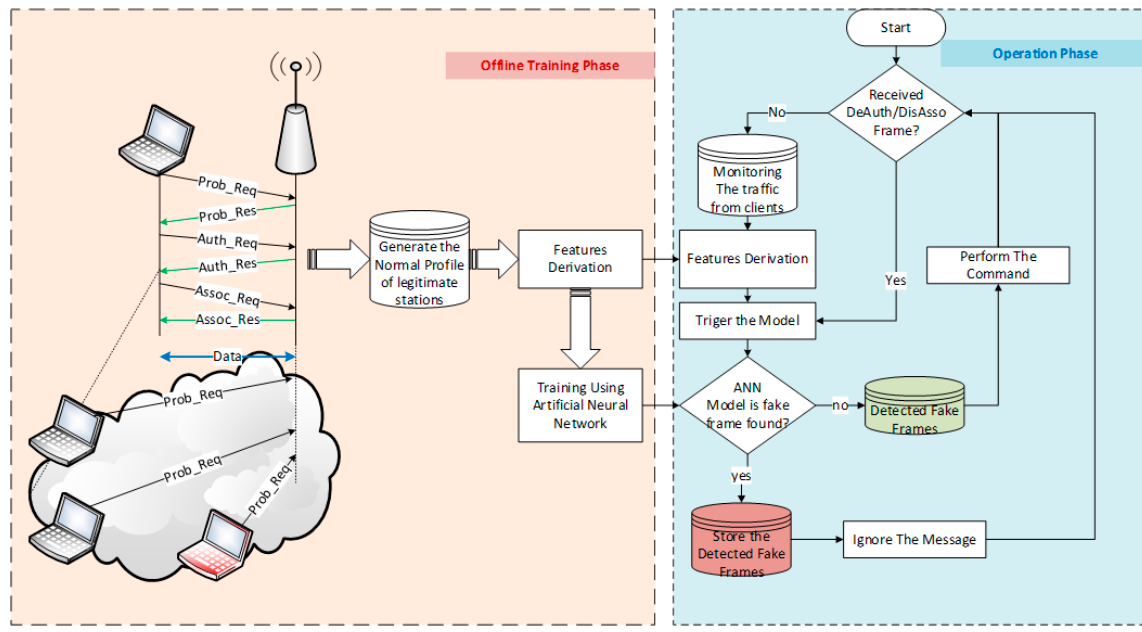
Figure 2. Online and offline